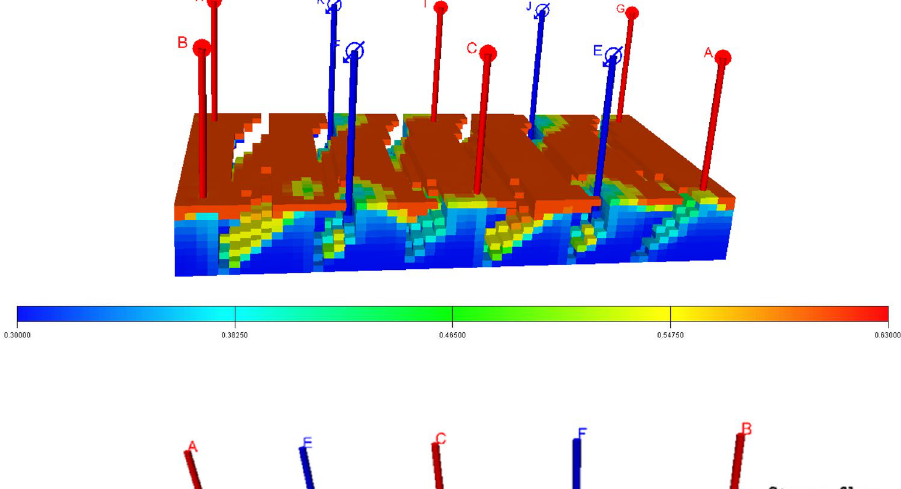
Fig. 8 The distribution of residual oil in the high water content period in point bar row well